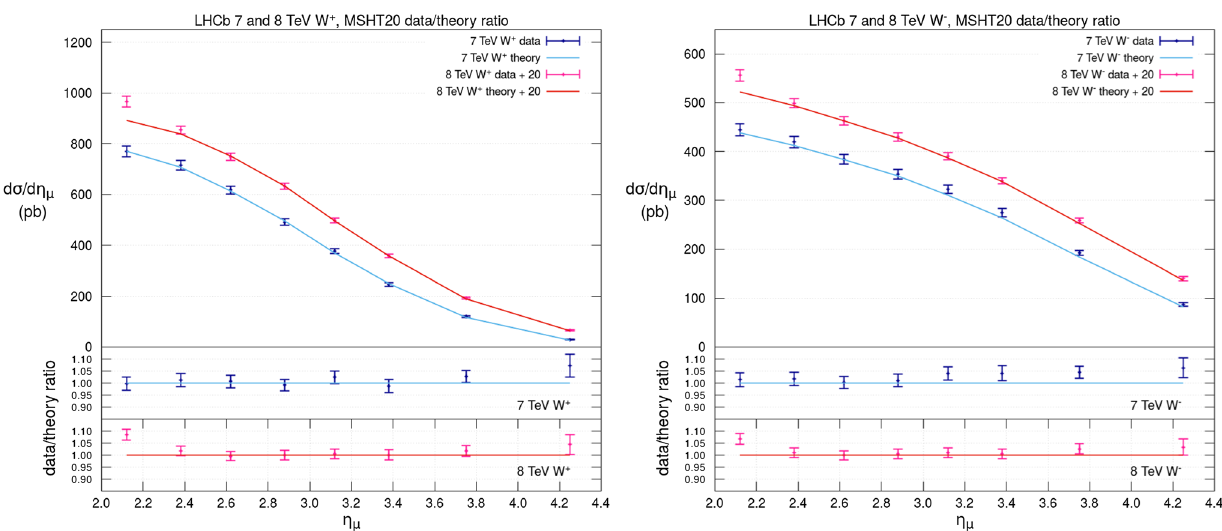
Fig. 8 Data vs. MSHT20 NNLO theory for the LHCb 7 and 8 TeV (left) W + and (right) W − data differential in the muon pseudorapidity, η μ . The errors plotted here are the total uncorrelated errors for each point